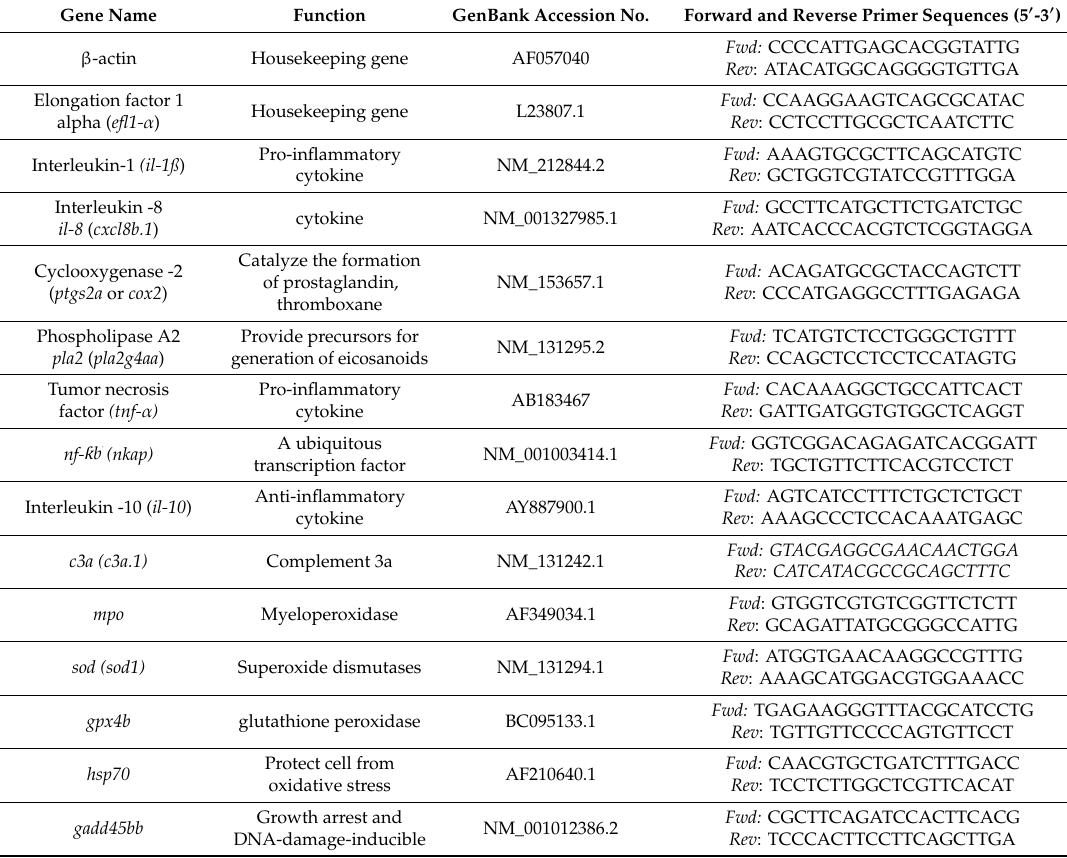
Table 1. Primer pairs used in this study.